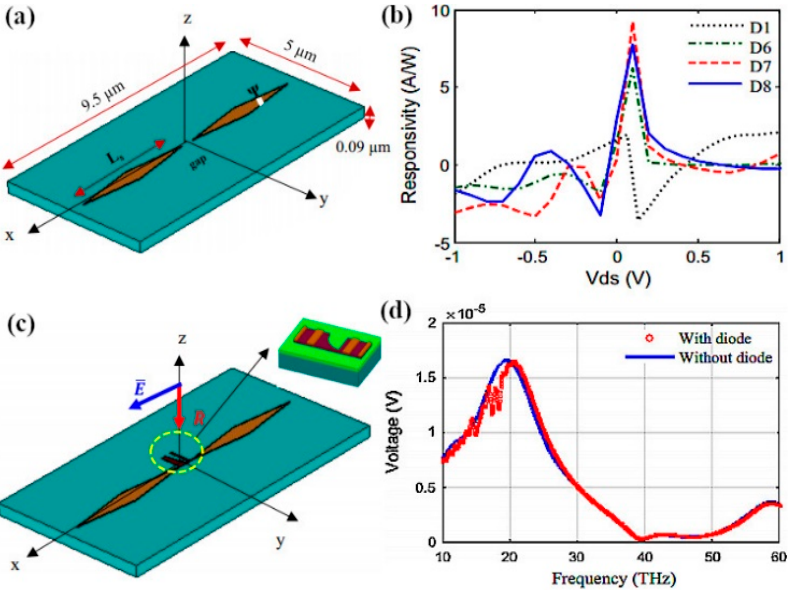
Figure 21. Graphene rectenna. ( a ) Schematic of a terahertz antenna designed to operate at terahertz frequency. ( b ) Responsivity of the graphene geometric diode with varying geometric parameters. ( c